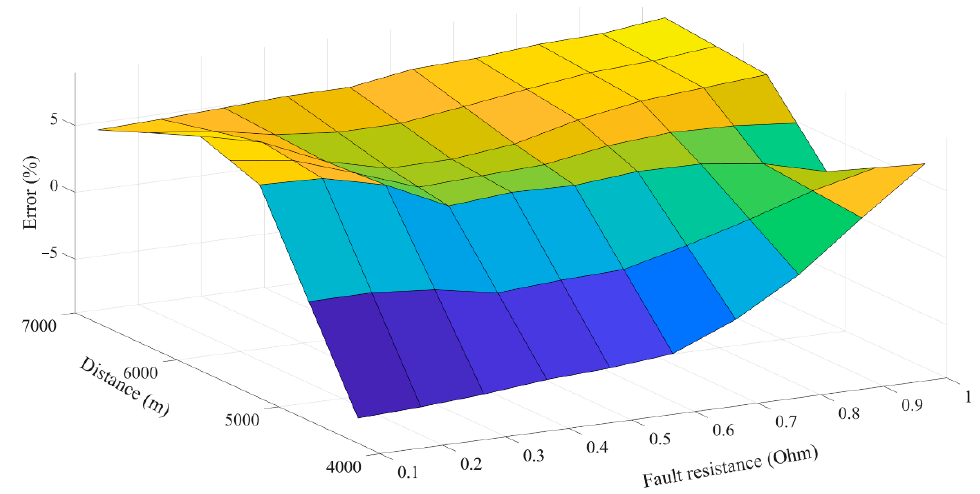
Figure 10. Accuracy evaluation of the proposed scheme.